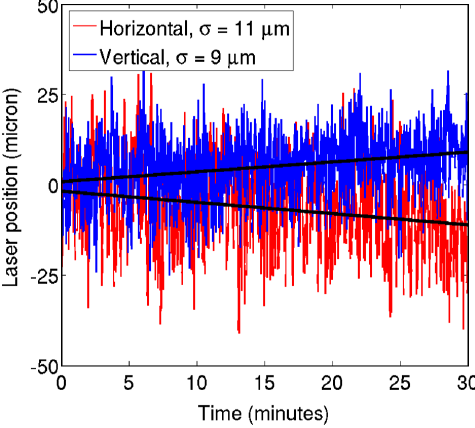
FIG. 16. Laser position stability versus the time.